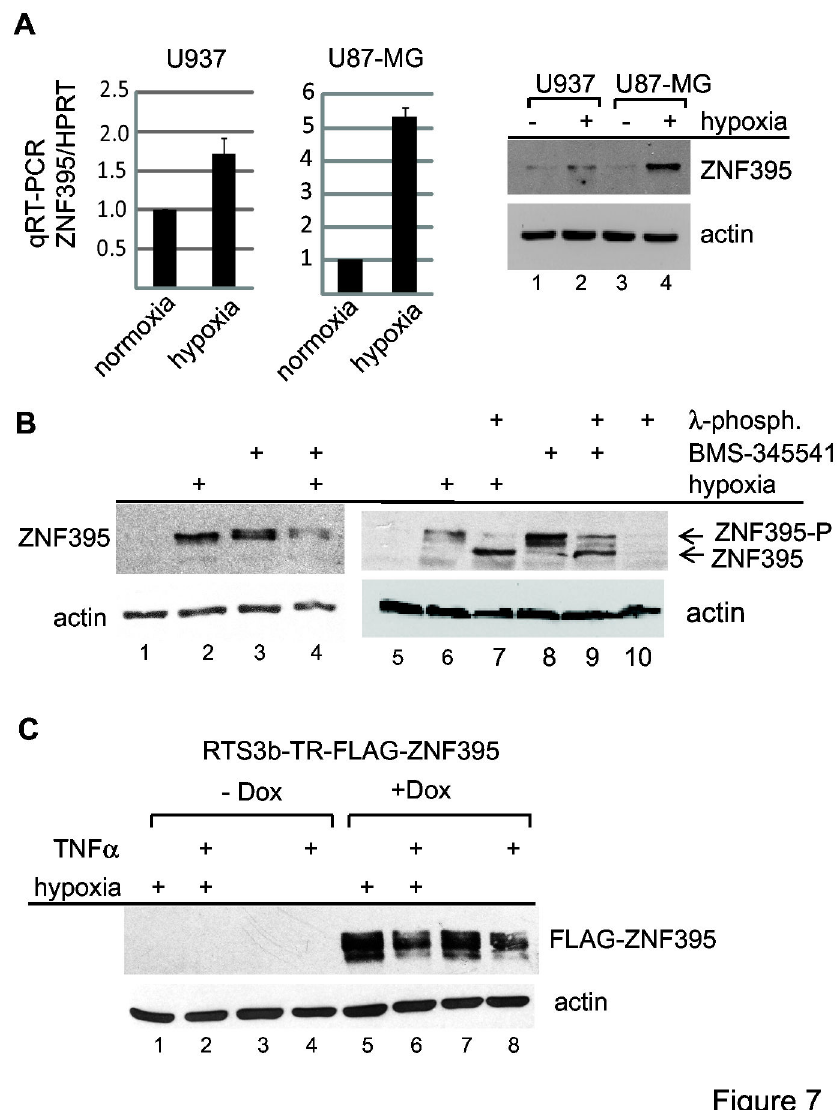
Figure 7. ZNF395 induced during hypoxia is modified by IKK. ( A ) U937 and U87-MG cells were either kept under normoxic or under hypoxic conditions (2% O atmosphere) for 12h before preparing total cell extracts or RNA. RNA was used for qRT-PCR to 2 analyze the expression of ZNF395, which was normalized to the expression of HPRT. The fold induction was calculated according the comparative threshold cycle [64]. 50µg of protein extracts were used for an IB with the anti-ZNF395. Actin served as the loading control. ( B ) U87-MG cells were grown in ambient or 2% O atmosphere and either treated with BMS-345541 or left untreated. Fifty 2 µg of total cell extracts were used in an IB to detect ZNF395. In lanes 7, 9 and 10, these extracts were incubated with λ- phosphatase, as indicated. ( C ) 15µg of extracts from RTS3b-TR-FLAG-ZNF395 cells grown in the absence or presence of Dox, hypoxia and TNFα, as indicated in the figure, were analyzed in a IB for the expression of ZNF395, and actin. α.